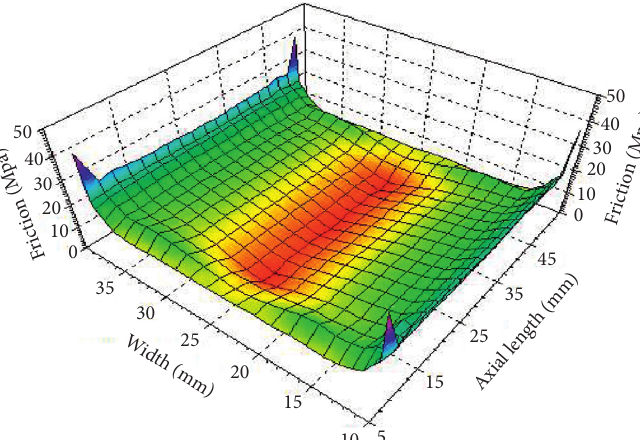
Figure 6: Friction distributions in the contact area.